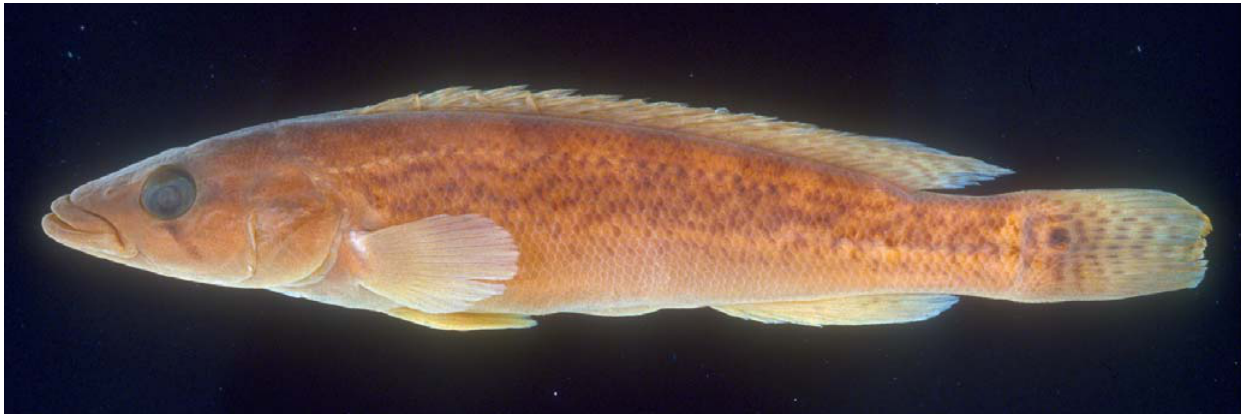
Fig. 5. Crenicichla iguapina , male, MZUSP 49062, holotype, 126.2 mm SL, Iporanga, rio Betari, rio Ribeira drainage, State of São Paulo,